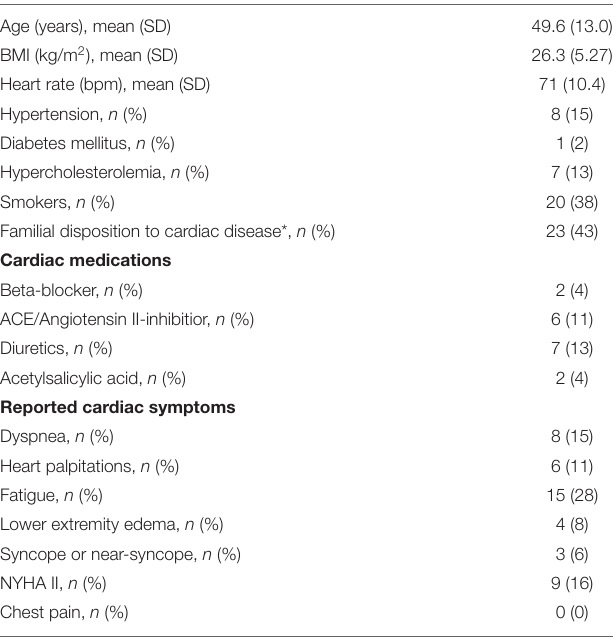
TABLE 1 | Baseline demographics for the 53 participating women. TABLE 2 | Skeletal and heart muscle biomarkers.